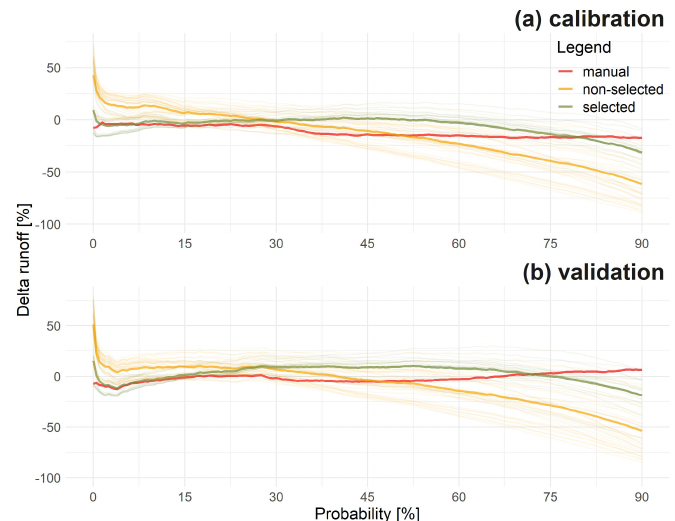
Figure 3. Runoff (( a )-calibration, ( b )-validation) relative difference probability curve (red line—manual calibration settings, green line—selected calibrations strategies, orange line—non-selected calibrations